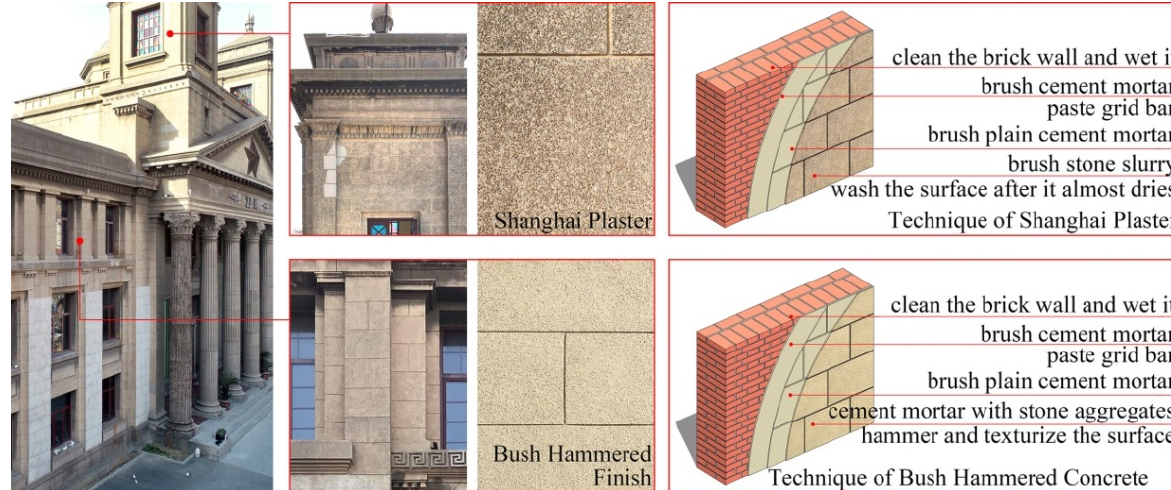
Figure 16. Construction Technology for the Surface Treatment.